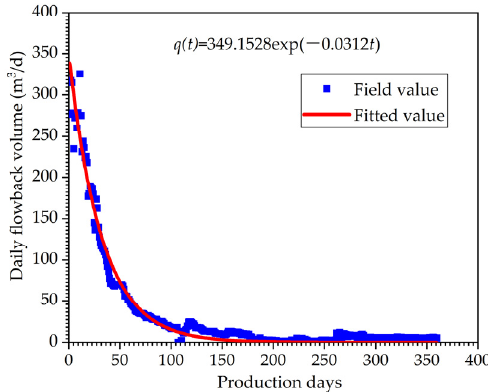
Figure 3. Field flowback curve for multistage fracturing of horizontal wells.